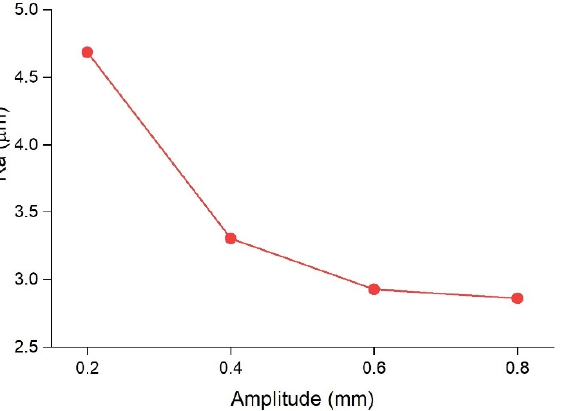
Figure 6. Roughness value (R a ) obtained for samples with 0.2 mm, 0.4 mm, 0.6 mm, and 0.8 mm oscillating amplitudes along the centre line of the welds. The oscillating frequency was kept constant at 200 Hz.